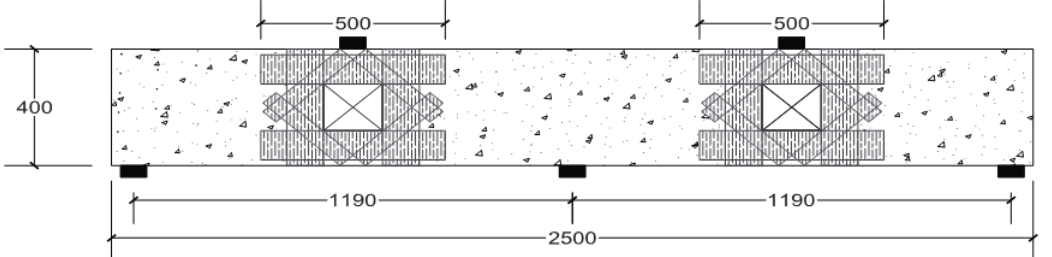
Figure 4. Illustration of the strengthening scheme with CFRP strips around openings of specimen CDB–O–S (all dimensions are in mm).